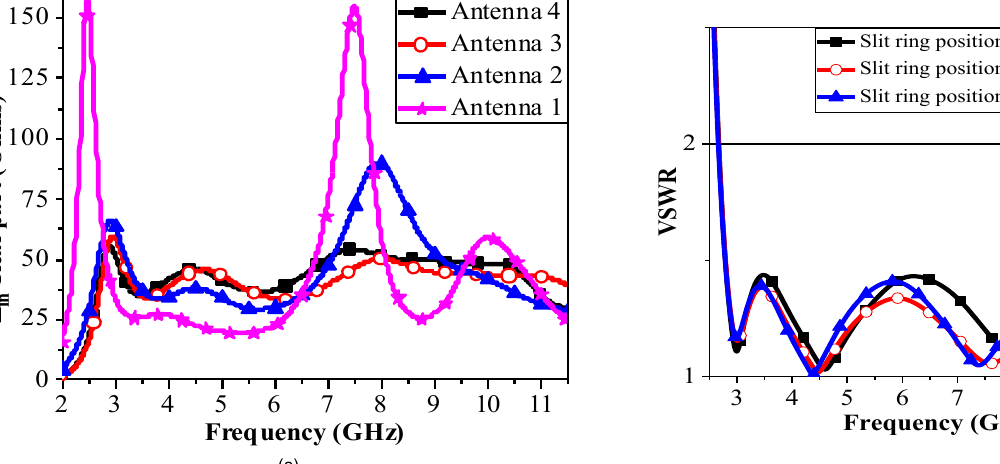
FIGURE 5. Simulated VSWR performance of the proposed antenna with and without P-shaped